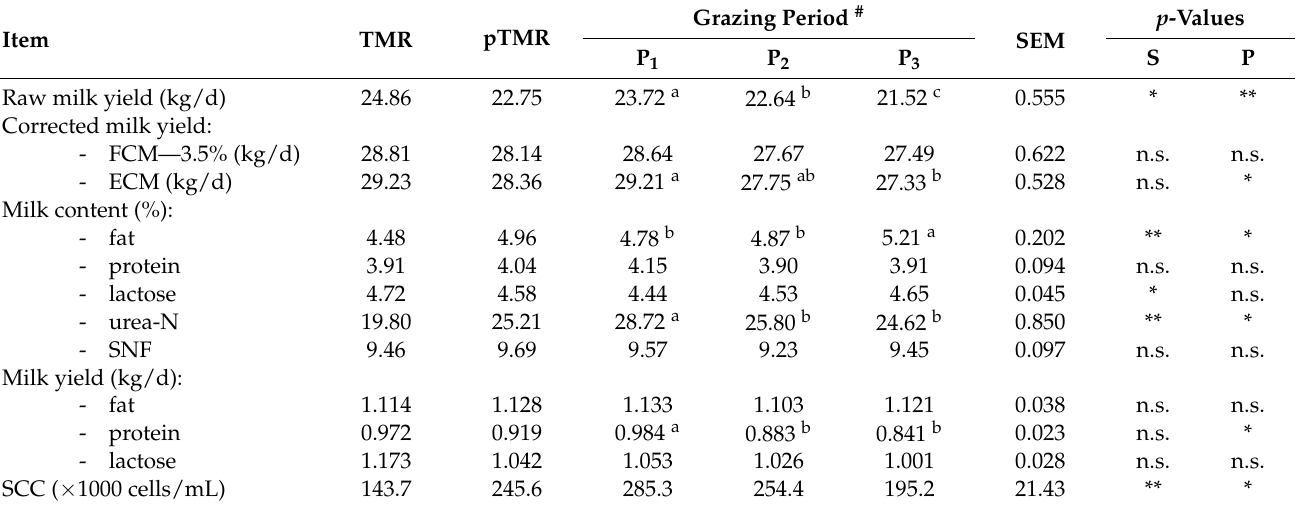
Table 3. Effect of cow feeding system (S: TMR vs. pTMR) and grazing period (P) on milk production and